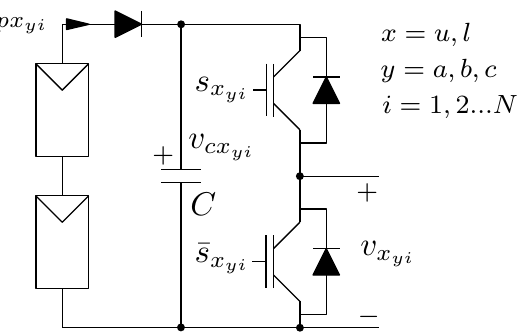
Figure 2. The PV string, two PV panels in series, is connected to the i th sub-module. A diode is included to avoid the power flow into PV